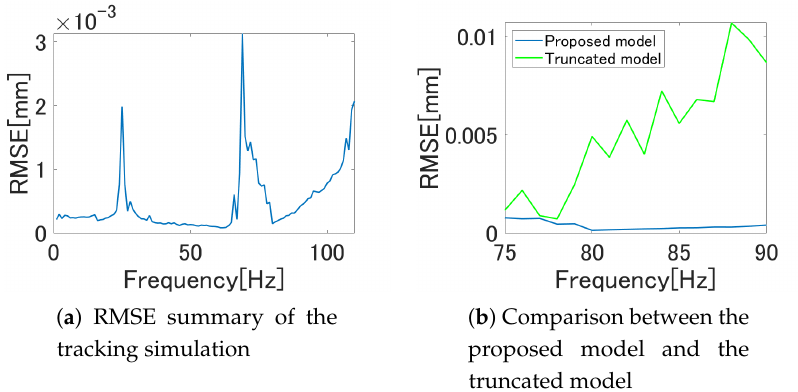
Figure 16. RMSE plots of hysteresis